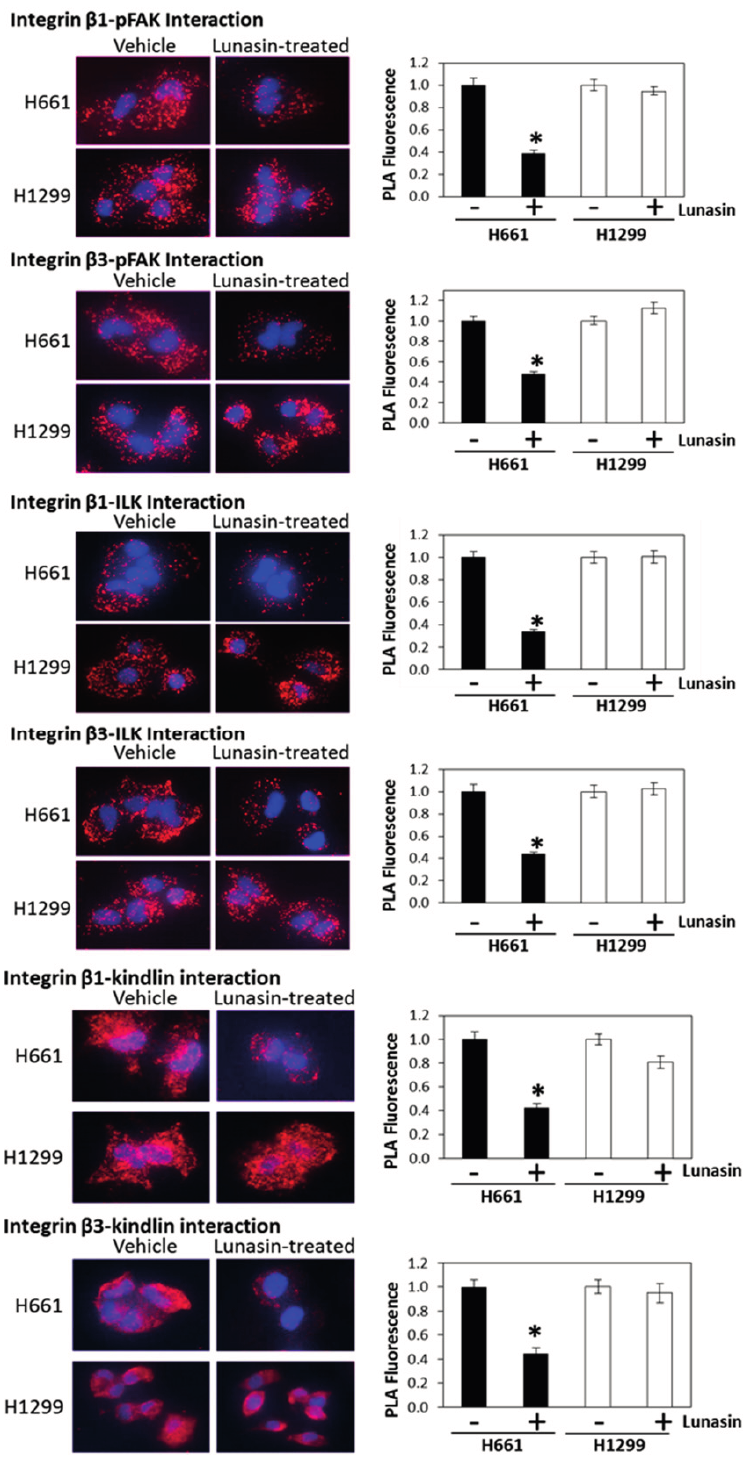
Figure 5. Detection of integrin β subunit interactions pFAK, Kindlin and ILK. Left-hand panels show representative PLA analyses of lunasin and the indicated integrin subunit. Right-hand panels show the quantitation of fluorescence for each interaction. Fluorescence is expressed as relative fluorescence per cell. Data shown are the mean ± SD obtained in three independent experiments; asterisks indicate statistically significant difference ( p < 0.05) from the vehicle-treated